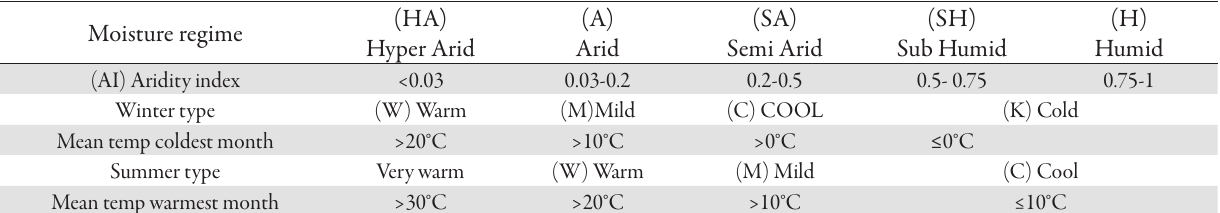
Tab. 1. Climatic indices used in UNESCO agroclimatic classification system (UNESCO, 1979)